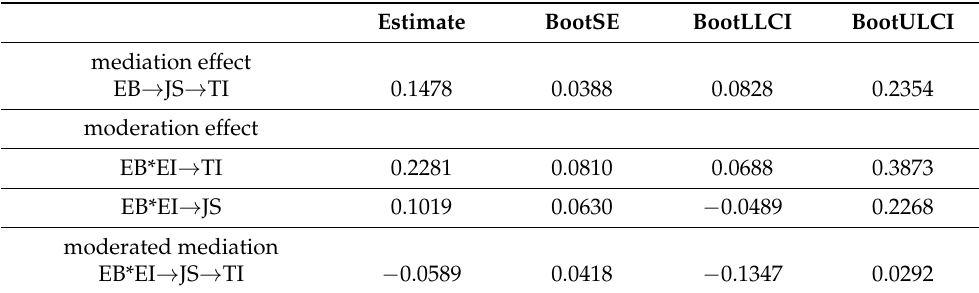
Table 6. Bootstrap mediation, moderation, and moderated mediation